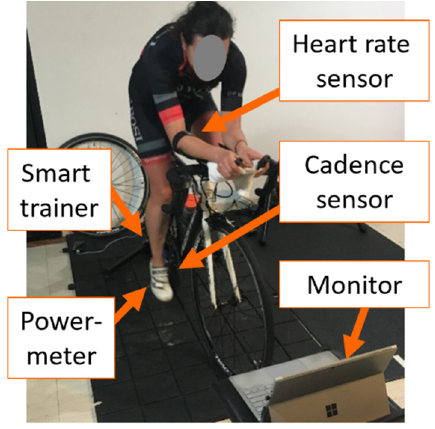
Figure 3. Setup for the characterization of the power delivery capacity.